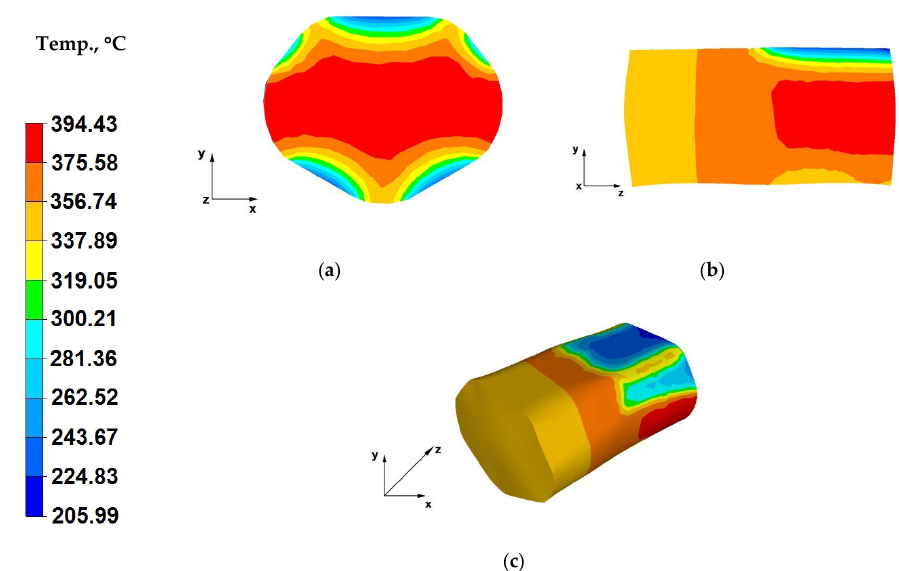
Figure 12. ( a ) Temperature distribution over the cross-section of an AZ91 alloy forging deformed within the second pass, with a relative reduction of 25%, in trapezoid-rhombic dies; ( b ) Temperature distribution over the longitudinal-section of an AZ91 alloy forging deformed within the second pass, with a relative reduction of 25%, in trapezoid-rhombic dies; ( c ) Axonometric view of the temperature distribution over the surface of an AZ91 alloy forged within the second forging pass, with a relative reduction of 25%, in trapezoid-rhombic dies.